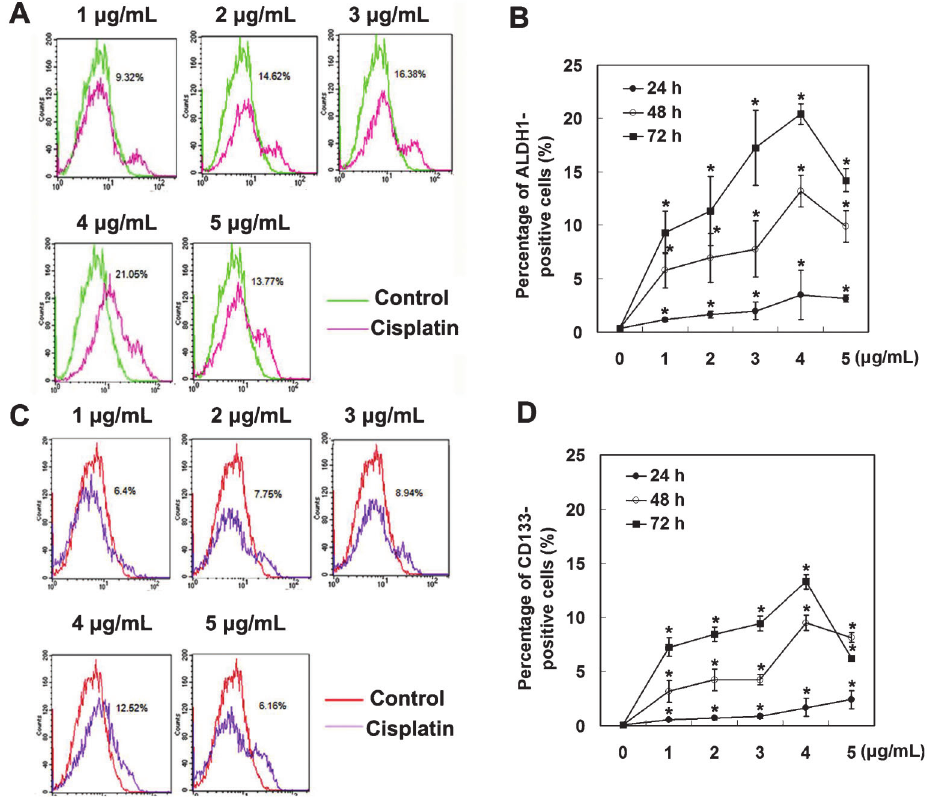
Figure 2. Flow cytometric analysis of the number of ALDH1++ and CD133++ cells. HepG2 cells were treated with 0-5 m g/mL cisplatin. The percentage of ALDH1++ ( A , B ) or CD133++ ( C , D ) cells at 24, 48, or 72 h following drug treatment was assessed by flow cytometric analysis. Data were calculated from three independent experiments. *P , 0.05 compared with 0 m g/mL cisplatin treatment ( x 2 test). Representative flow cytometry data are presented in Panels A and C